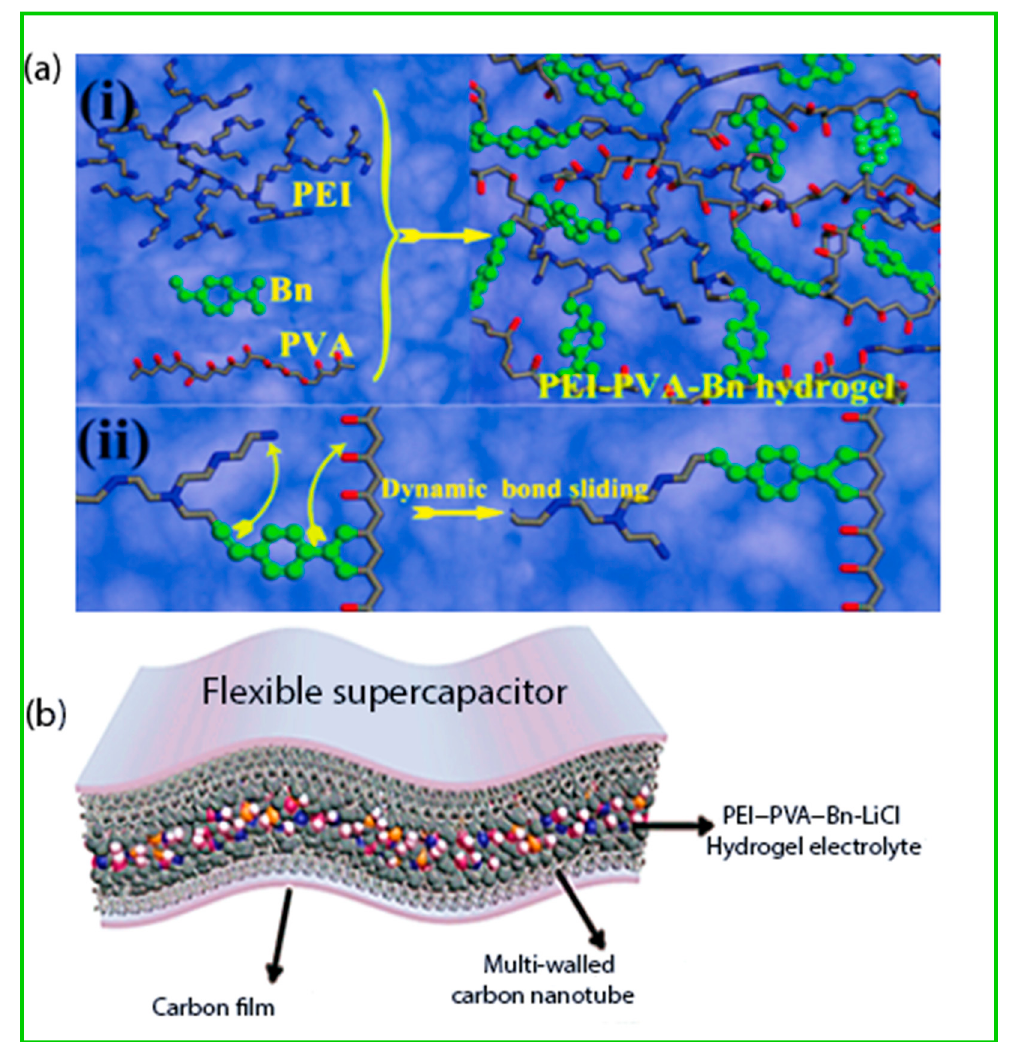
Figure 18. ( a ) The structure of the PEI − PVA − Bn hydrogel network ( i ) and the sliding development of the dynamic cross-linking sites. ( ii ) Graphical presentation of the SC consisting the PEI − PVA − Bn-LiCl-1 hydrogel electrolyte and MWCNT electrode. ( b ) Reprinted with permission from [353], Copyright 2020, American Chemical Society.